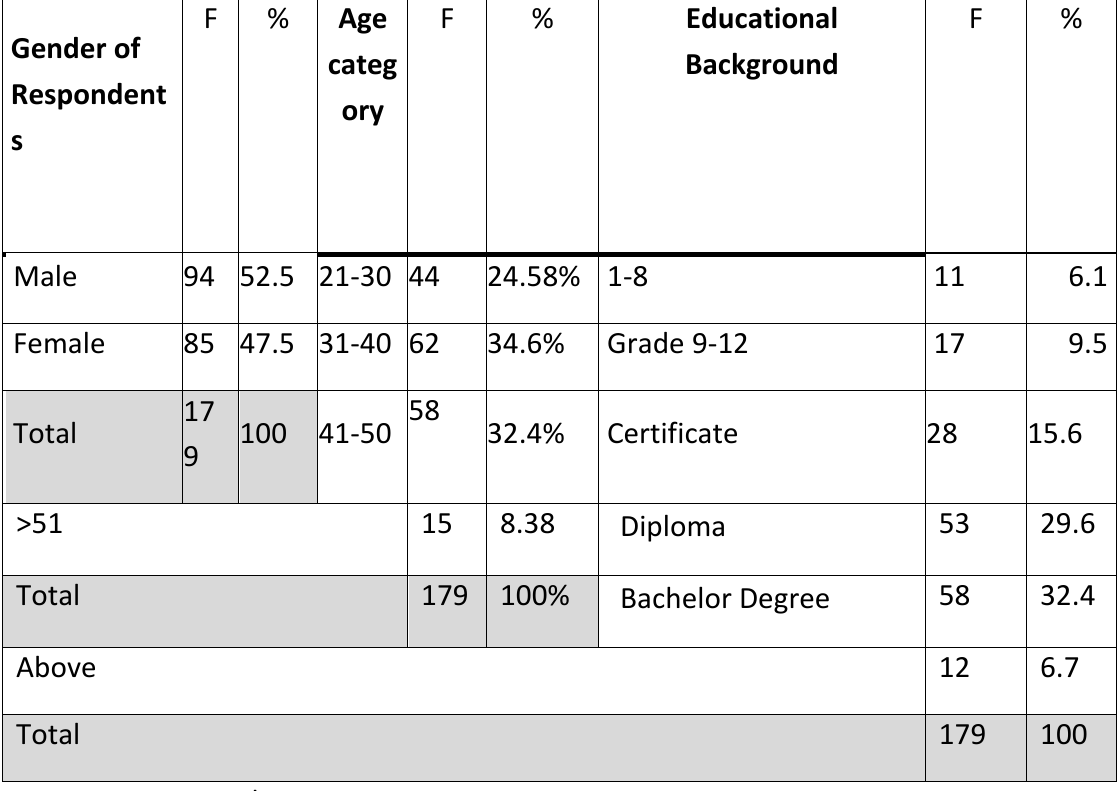
Table 3: Percent Distribution of Respondents by Gender, Age, and Educational Background Gender